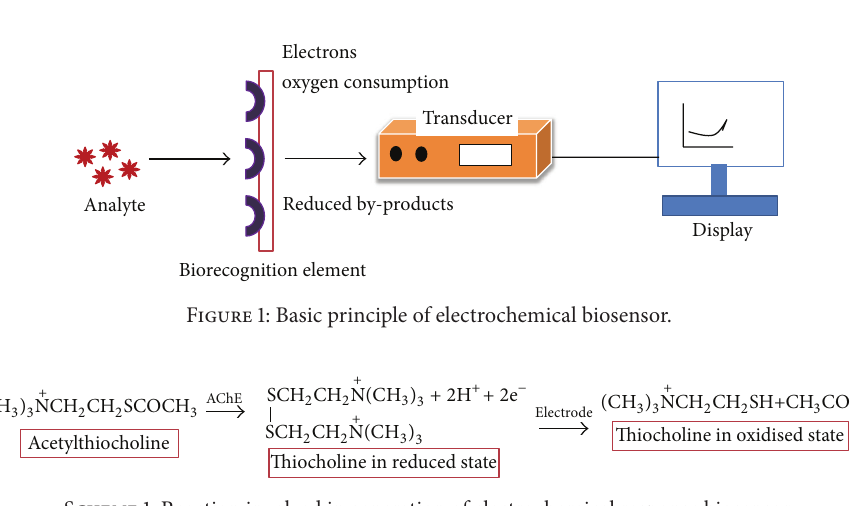
Scheme 1: Reaction involved in generation of electrochemical response